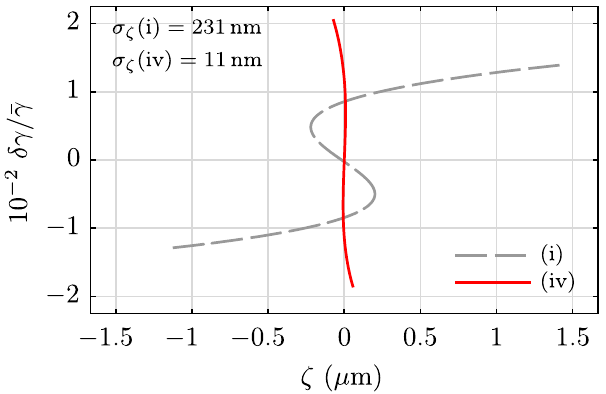
FIG. 9. Comparison of case (i) and (iv) at the focus position 5 . 50 m. The second order contribution vanishes in both z F ¼ cases, however, in case (i) a strong, negative third order is visible — expressed by the S-shaped phase space figure. In case (iv), the magnitude of the third order is much less; in addition, the S-shape changed to Z, meaning that X 3 is slightly positive for the parameter set chosen.